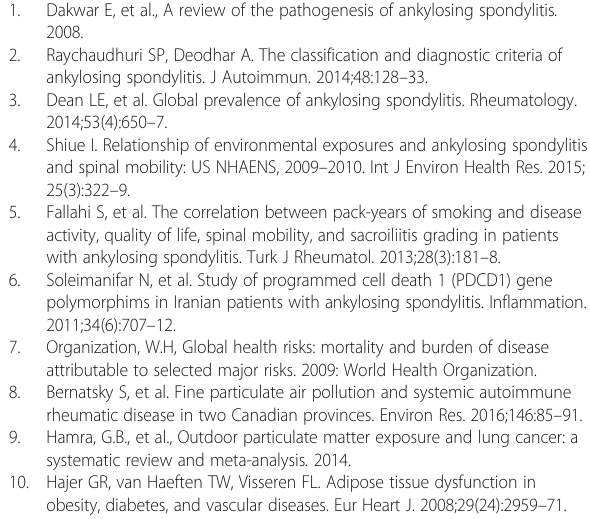
SF Saturated fat of food, MUFA Mono unsaturated fatty acids, PUFA Poly unsaturated fatty acids, NS Not